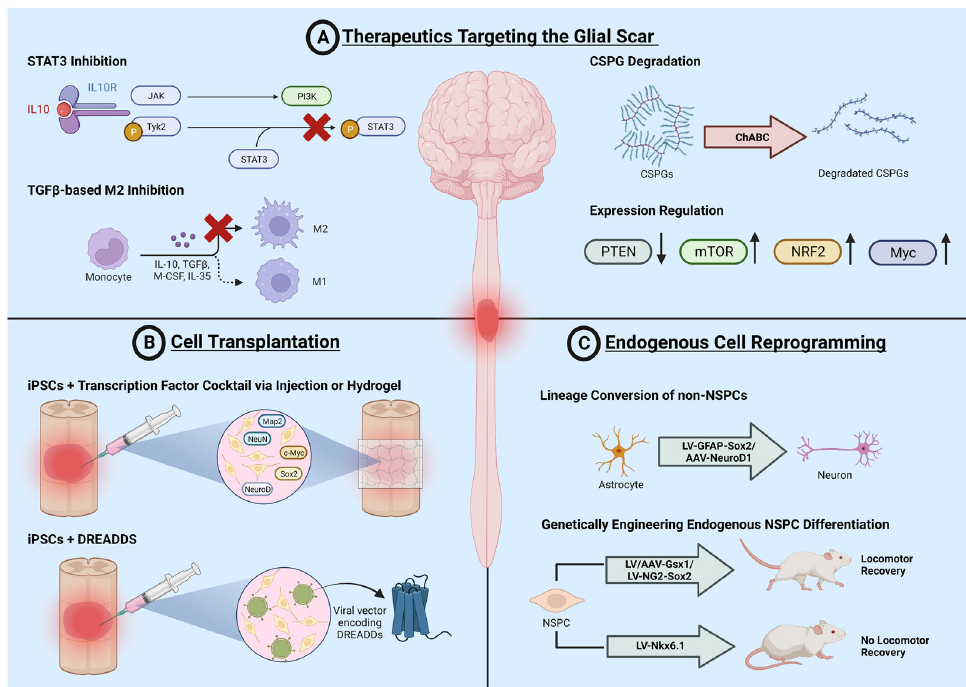
Figure 2. Current research in therapeutic interventions. Current cellular and molecular strategies to treat SCI include ( A ) therapeutics targeting the glial scar, ( B ) cell transplantation, and ( C ) endogenous cell reprogramming. These strategies each have their own pros and cons, with new genetic and biotechnological advances regularly changing the landscape of each type. Advances in each field over the last 5–10 years are highlighted in the following sections.